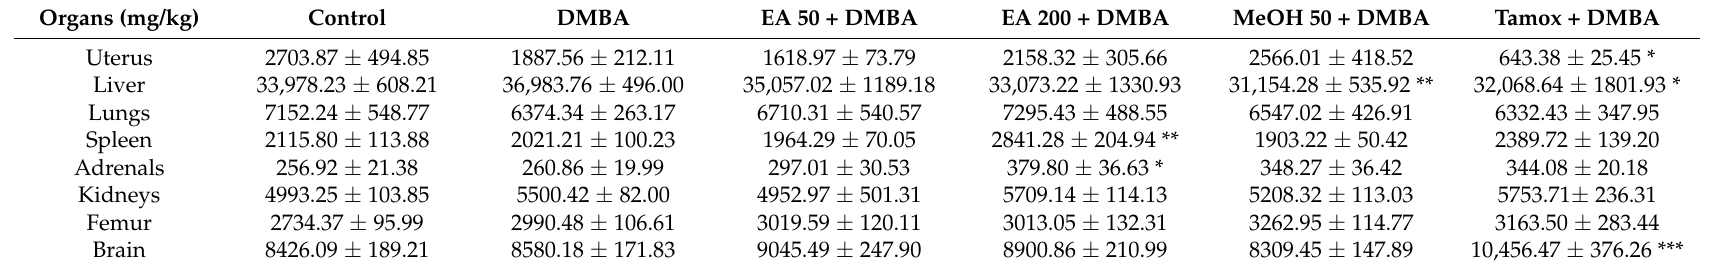
Table 5. Effects of F. umbellata extracts on relative weight of various organs after 20 weeks of treatment.